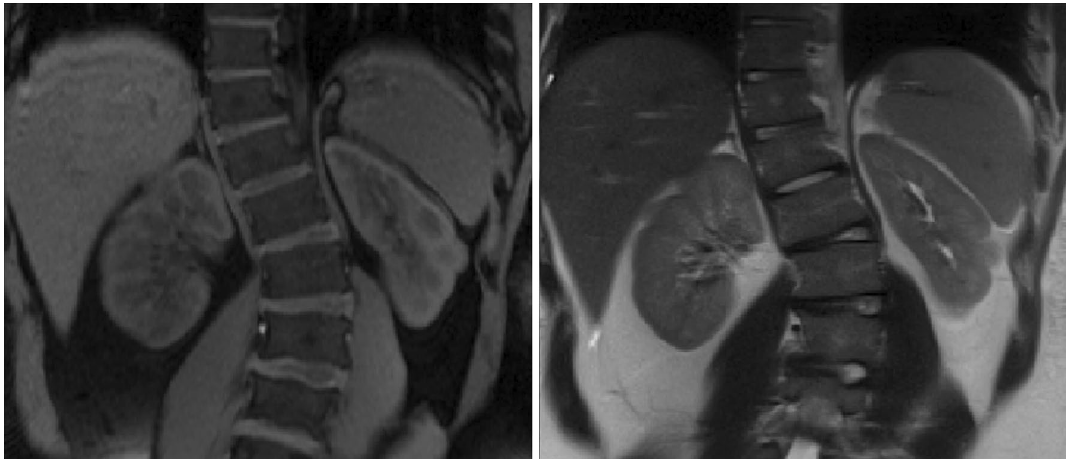
Figure 3. T1- (left) and T2-weighted (right) MRI images of a BBS subject included in the present study. The morphological analysis shows fetal lobulations at the inferior pole of the left kidney.